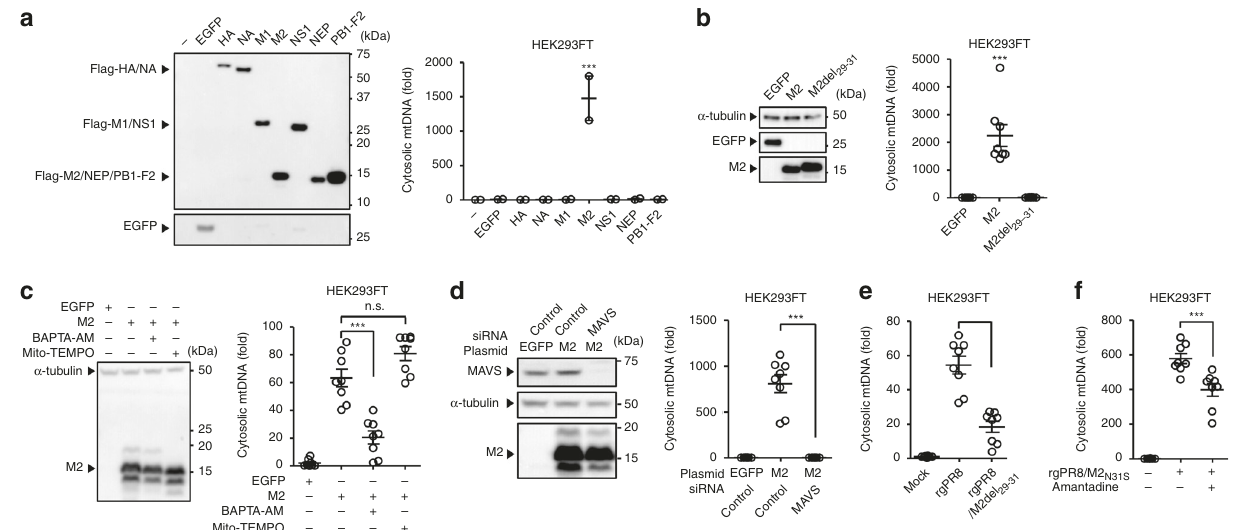
Fig. 2 Ion channel activity of in fl uenza virus M2 protein is essential for mtDNA release. a HEK293FT cells were transfected with the expression plasmid encoding EGFP or Flag-tagged in fl uenza virus proteins. Cell lysates were collected at 24 h post transfection and analyzed by immunoblot with mouse monoclonal antibody against Flag or EGFP (left panel). Cytosolic mtDNA was assessed by quantitative PCR at 24 h post transfection (right panel). b HEK293FT cells were transfected with the expression plasmid encoding EGFP or Flag-tagged WT or mutant M2 protein. Cell lysates were collected at 24 h post transfection and analyzed by immunoblot using indicated antibodies (left panel). Cytosolic mtDNA was assessed by quantitative PCR at 24 h post transfection (right panel). c HEK293FT cells were transfected with the expression plasmid encoding EGFP or Flag-tagged M2 protein in the presence or absence of BAPTA-AM (20 μ M) or Mito-TEMPO (500 μ M). Cell lysates were collected at 24 h post transfection and blotted using the indicated antibodies (left panel). Cytosolic mtDNA was assessed by quantitative PCR at 24 h post transfection (right panel). d HEK293FT cells were transfected with siRNA targeting MAVS or control siRNA. Two days later, cells were transfected with the expression plasmid encoding EGFP or Flag-tagged M2 protein. Cell lysates were collected at 24 h post DNA transfection and blotted using the indicated antibodies (left panel). Cytosolic mtDNA was assessed by quantitative PCR at 24 h post DNA transfection (right panel). e , f HEK293FT cells were infected with WT (rgPR8), M2del29 – 31 virus (rgPR8/M2del29 – 31) ( e ), or amantadine sensitive-recombinant in fl uenza virus (rgPR8/M2 N31S ) in the presence or absence of amantadine (100 μ M) ( f ). Cytosolic mtDNA was assessed by quantitative PCR at 24 h post infection. These data are from three independent experiments ( a – f ; mean ± s.e.m.). *** P < 0.001; n.s., not signi fi cant (one-way ANOVA and Tukey ’ s test). Source data are provided as a Source Data fi